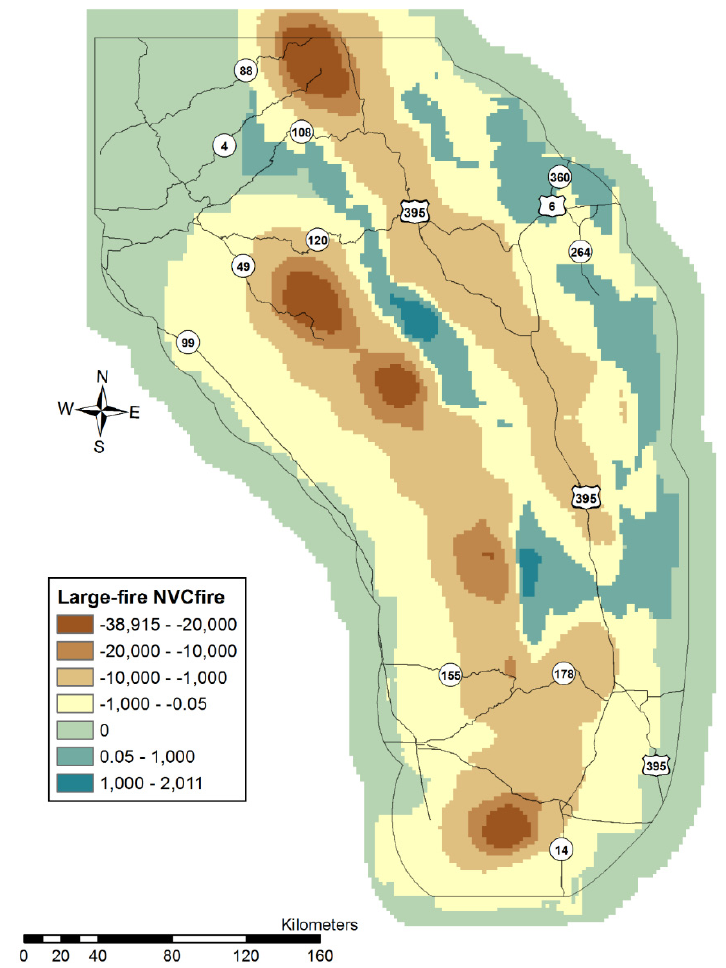
Figure 9. Large ‐ fires simulated as a source of risk as measured by large ‐ fire net value change ( NVC fire ). Figure 9. Large-fires simulated as a source of risk as measured by large-fire net value change ( NVC fire